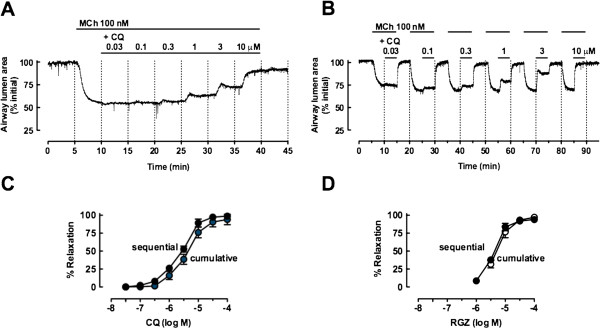
Rosiglitazone and chloroquine elicit concentration-dependent relaxation in mouse small airways in lung slices. Airways in lung slices were pre-contracted with 100 nM methacholine (MCh), prior to perfusion with chloroquine (CQ) or rosiglitazone (RGZ). Representative traces showing changes in airway lumen area during A) cumulative perfusion and B) sequential additions of CQ. C) D) Grouped data for CQ (n = 4/group) and RGZ (n = 4/group) added cumulatively or sequentially. Responses (mean ± S.E.M) represent the% relaxation of the pre-contraction to MCh, averaged over the last minute of perfusion at each dilator concentration.